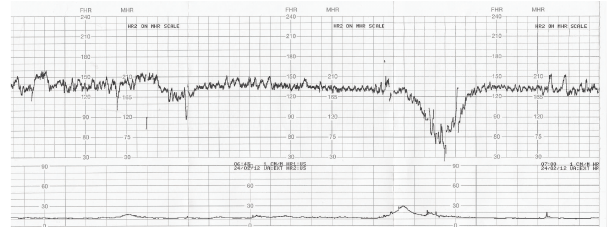
Figure 2: Cardiotocographic (CTG) monitoring revealed a late type of deceleration after a mild uterine